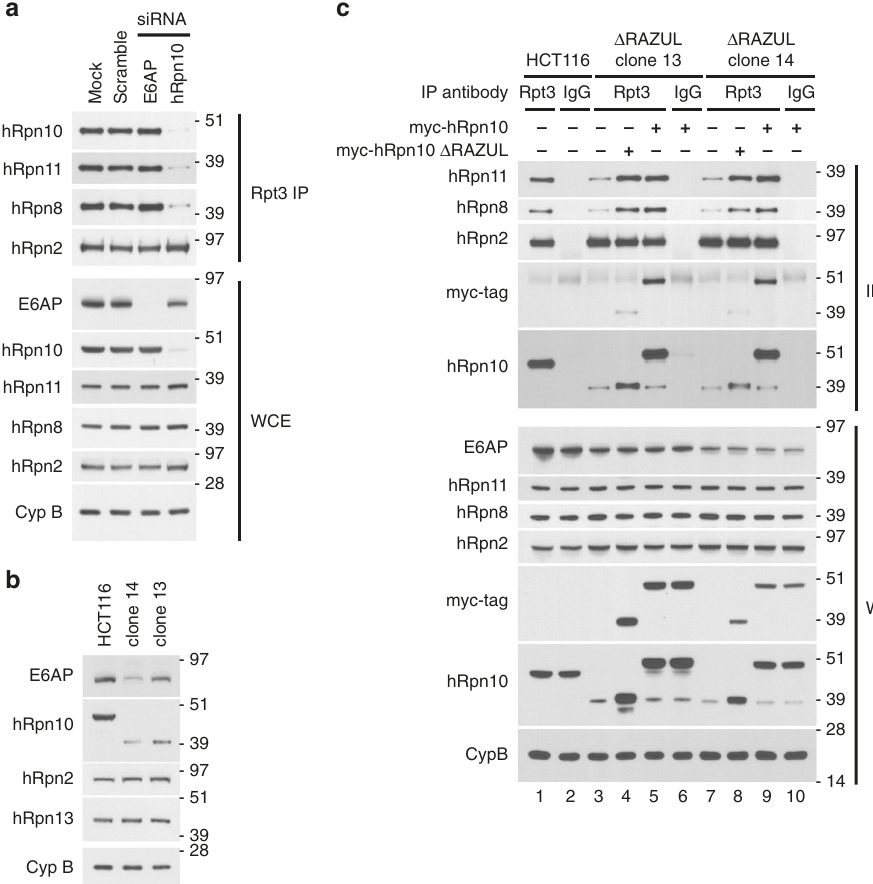
Fig. 2 Levels of proteasome lid-base association correlate with hRpn10 levels. a Lysates from HCT116 cells transfected with siRNAs to E6AP or hRpn10, as well as mock and scrambled control samples, were immunoprecipitated with Rpt3 antibodies. WCE and immunoprecipitates were immunoprobed as indicated. Cyclophilin B (Cyp B) is used as a loading control in a – c . b Immunoblots of parental HCT116 cells and two clonal cell lines (clone 14 and clone 13) generated by CRISPR-mediated truncation of hRpn10. c Δ RAZUL cells shown in b were transfected with full length or Δ RAZUL hRpn10 constructs and subjected to hRpt3 immunoprecipitation. Lysates or immunoprecipitates were probed with antibodies as indicated to the left of each panel. Source data are provided as a Source Data fi